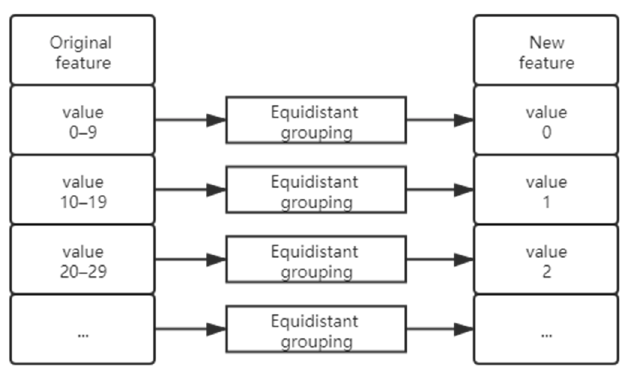
Figure 2. Example of constructing a new feature by equidistance. histogram [20] for a normally distributed